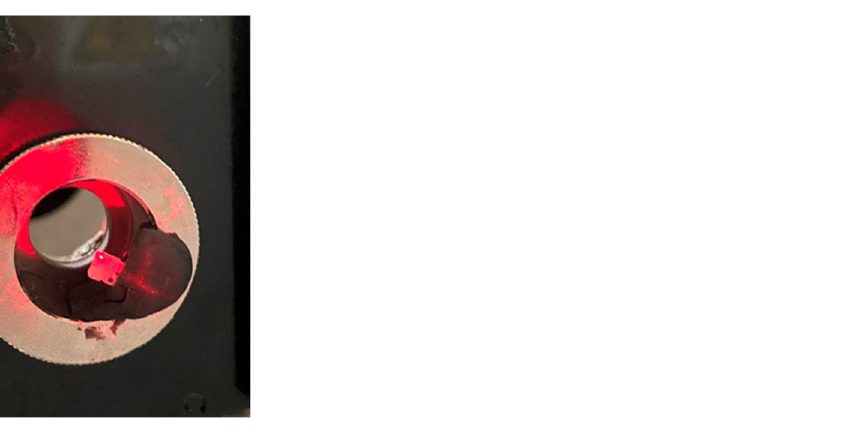
Figure 2. Positioning of the aesthetic bracket with the laser aimed at the occlusal distal wing.